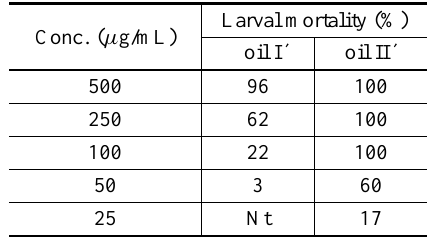
Larvicidal activity of the essential oils from leaves of P. apodocephala (oil I’) and P. oligocephala (oil II’). Larval mortality (%) Conc. ( µ